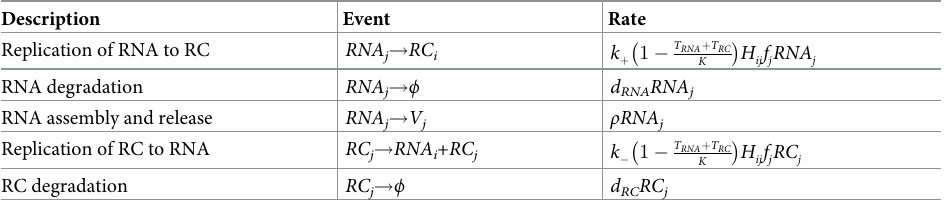
Table 2. Events in the intracellular model along with their rates. The symbols and their meanings are described in the text. Parameter values are in Table 1.